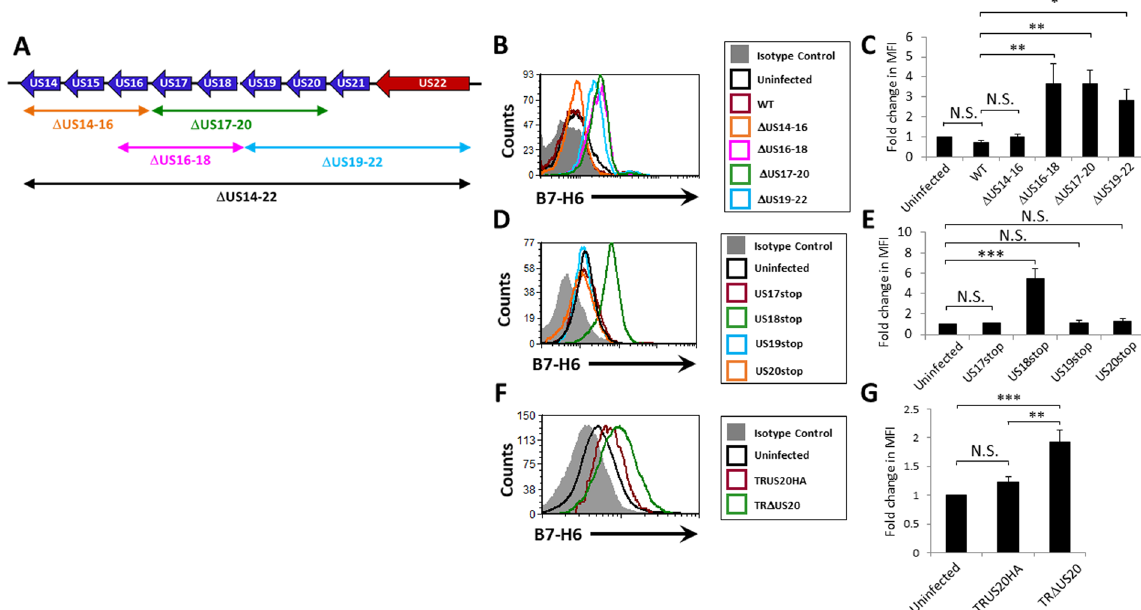
Figure 2. HCMV US18 and US20 are responsible for the B7-H6 downregulation phenotype. ( A ) Schematic representation of HCMV US14-US22 genomic region and the different block deletion mutants used in this study. Blue arrows represent US12-family genes. Red arrows represent US22-family genes. Double headed arrows represent genomic regions deleted in the different block-deletion mutants. ( B ) FACS staining of B7-H6 surface expression on ARPE19 cells infected with different HCMV TB40/e strains deleted for gene blocks within the US14-22 genomic region. Histogram colors are as depicted in the figure legend. One representative experiment out of seven is presented. No significant differences were observed between isotype control stainings of each infection, so a representative isotype control staining derived from the uninfected cells is presented. ( C ) Quantification of the results presented in B. Averages of seven experiments are presented. Error bars represent standard error of the mean. ( D ) FACS staining of B7-H6 surface expression on ARPE19 cells infected with different HCMV TB40/e strains in which the start codon of one ORF out of the US17-20 region was replaced with a stop codon. Histogram colors are as depicted in the figure legend. One representative experiment out of three is presented. No significant differences were observed between isotype control stainings of each infection, so a representative isotype control staining derived from the uninfected cells is presented. ( E ) Quantification of the results presented in D. Averages of three experiments are presented. Error bars represent standard error of the mean. ( F ) FACS staining of B7-H6 surface expression on ARPE19 cells infected with different HCMV TR derivatives. Histogram colors are as depicted in the figure legend. One representative experiment out of four is presented. No significant differences were observed between isotype control stainings of each infection, so a representative isotype control staining derived from the uninfected cells is presented. ( G ) Quantification of the results presented in F. Averages of four experiments are presented. Error bars represent standard error of the mean. ANOVA tests were performed in order to evaluate significance. * p-value < 0.05. ** p-value < 0.005. *** p-value < 0.0005. N.S. = non-significant differences.